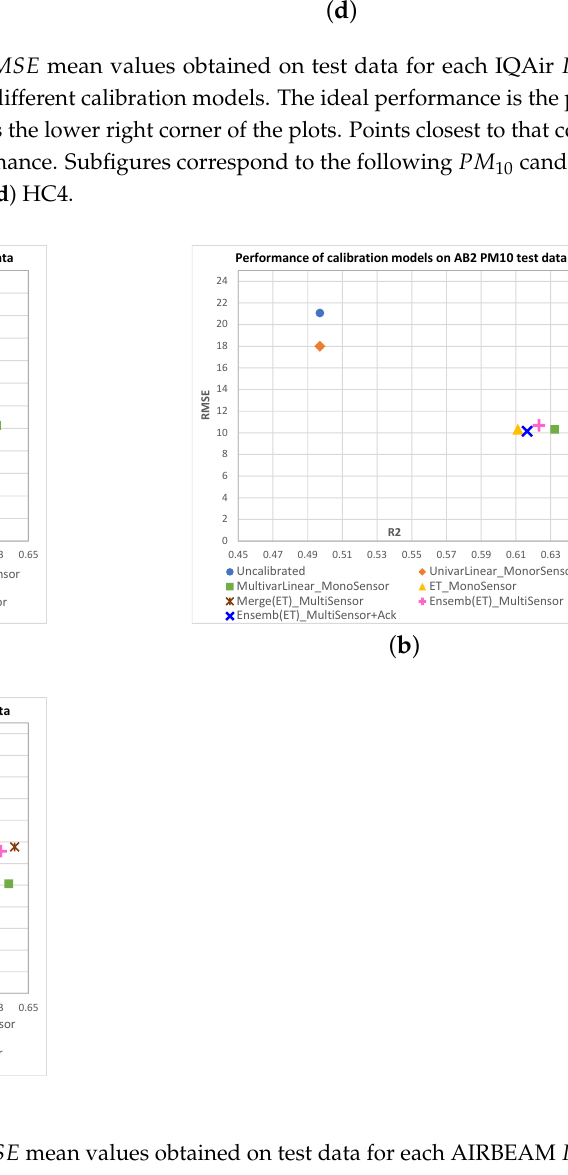
Figure 11. Scatterplots of R 2 vs. RMSE mean values obtained on test data for each AIRBEAM PM 10 sensor as candidate sensor with the different calibration models. The ideal performance is the point with RMSE = 0 and R 2 = 1, which is the lower right corner of the plots. Points closest to that corner represent models with better performance. Subfigures correspond to the following PM 10 candidate sensors: ( a ) AB1; ( b ) AB2; ( c )